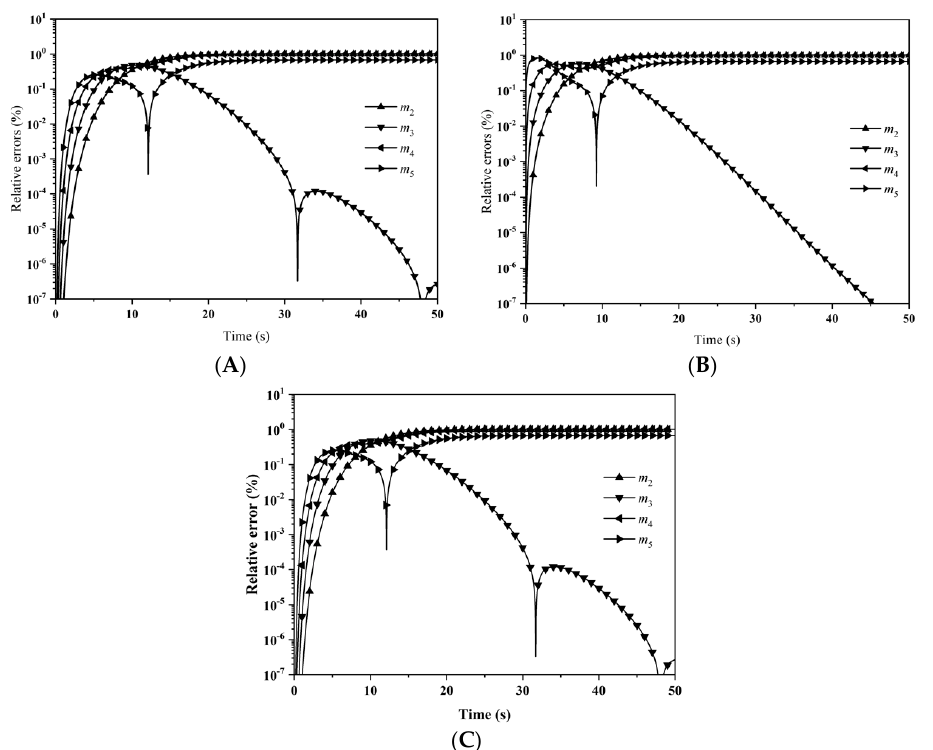
Figure 19. Relative errors for m 2 – m 5 for the aggregation and breakage combined process with constant aggregation kernel, linear breakage kernel, uniform daughter distribution, and exponential initial PSD with: ( A ) LFPQMOM; ( B ) QMOM; and ( C ) FPQMOM (up triangle: m 2 ; down triangle: m 3 ; left triangle: m 4 ; right triangle: m 5 ).